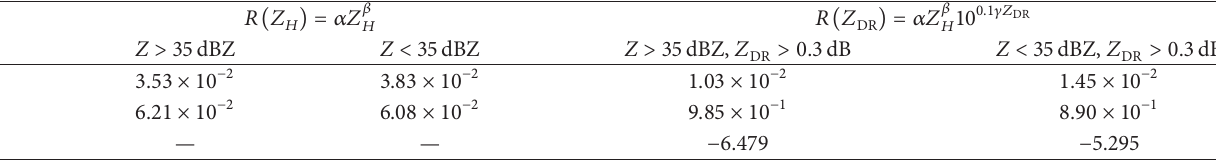
Table 3: Two rain rate retrieval algorithms and boundary conditions